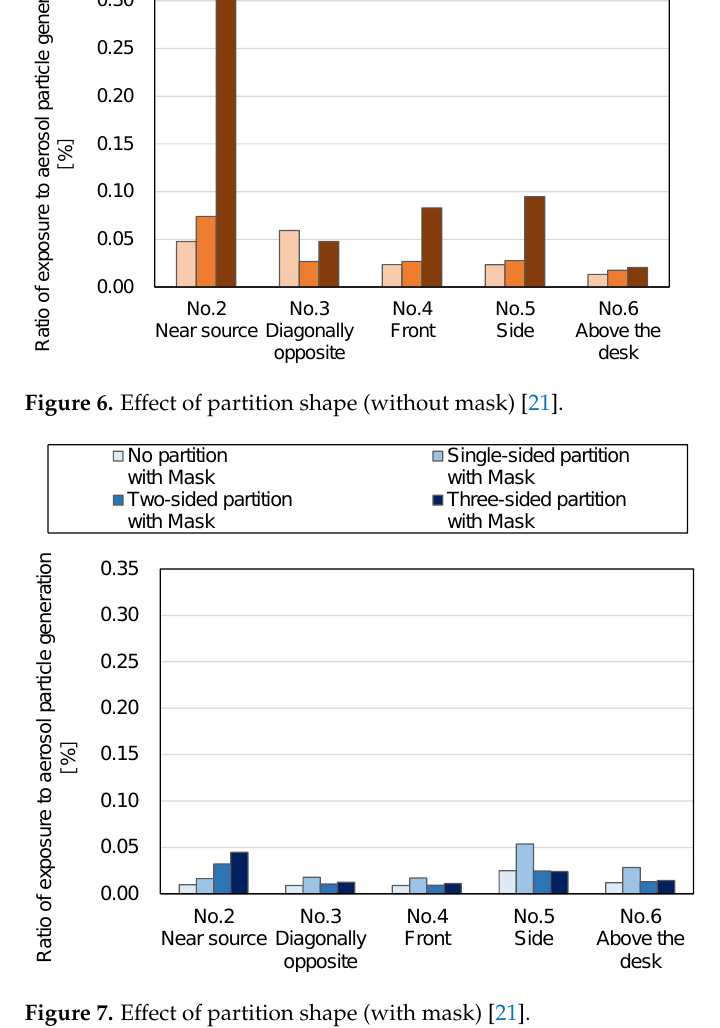
Figure 7. Effect of partition shape (with mask) [21]. 3.3. Effective Ventilation Methods in an Emergent Proposal by Subcommittee on Novel Coronavirus Disease Control (14 July 2022) In July 2022, the governmental subcommittee on Novel Coronavirus Disease Control provided an emergent proposal about effective ventilation methods to prevent two types of aerosol infection; infection by large aerosol on the air current and infection by small floating aerosol diffusion in a room. They also showed the way of setting droplet preven- tion partitions, which do not block off ventilation based on this investigation results.